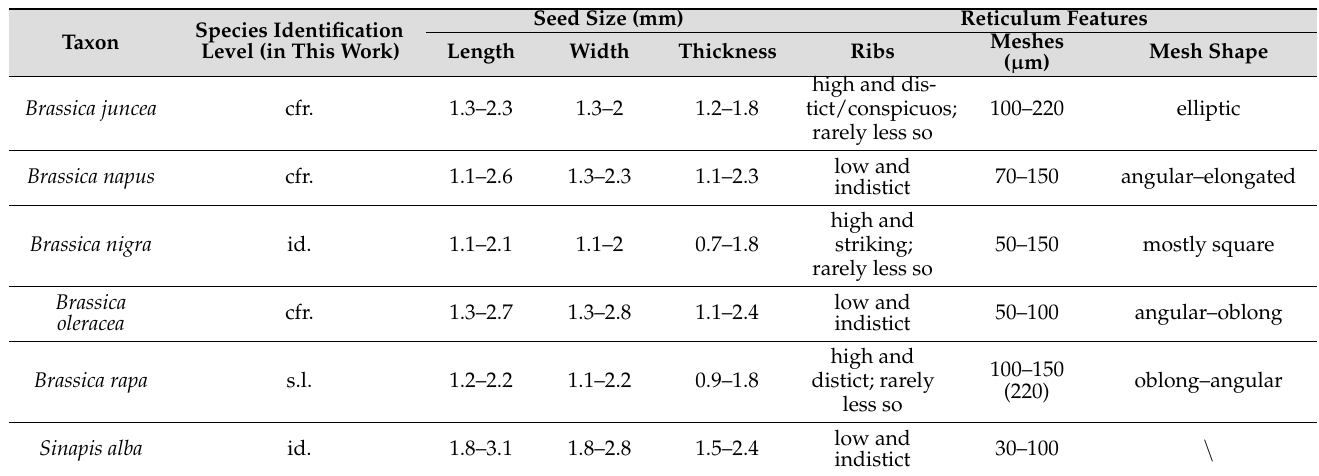
Table 5. Diagnostic characters used to distinguish the five principal species found during this study. Only minimum and maximum values of seed size are